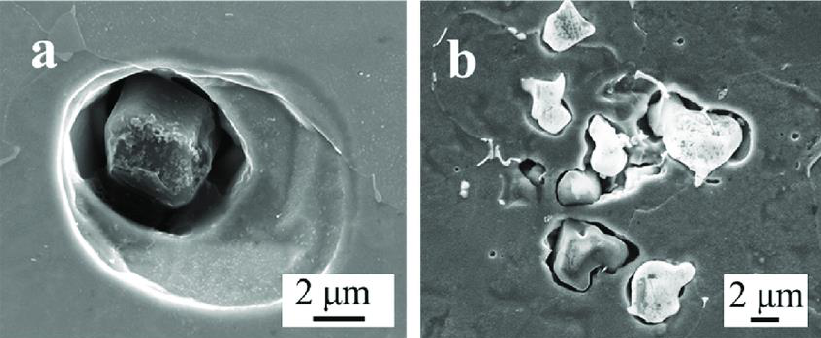
Figure 4. FE-SEM image of pits in steel. ( a ) The morphology of the pit around a single Al 2 O 3 inclusion; ( b ) the pit morphology of the Al 2 O 3 inclusion cluster [13]. Reproduced with permission of Elsevier, copyright 2018.